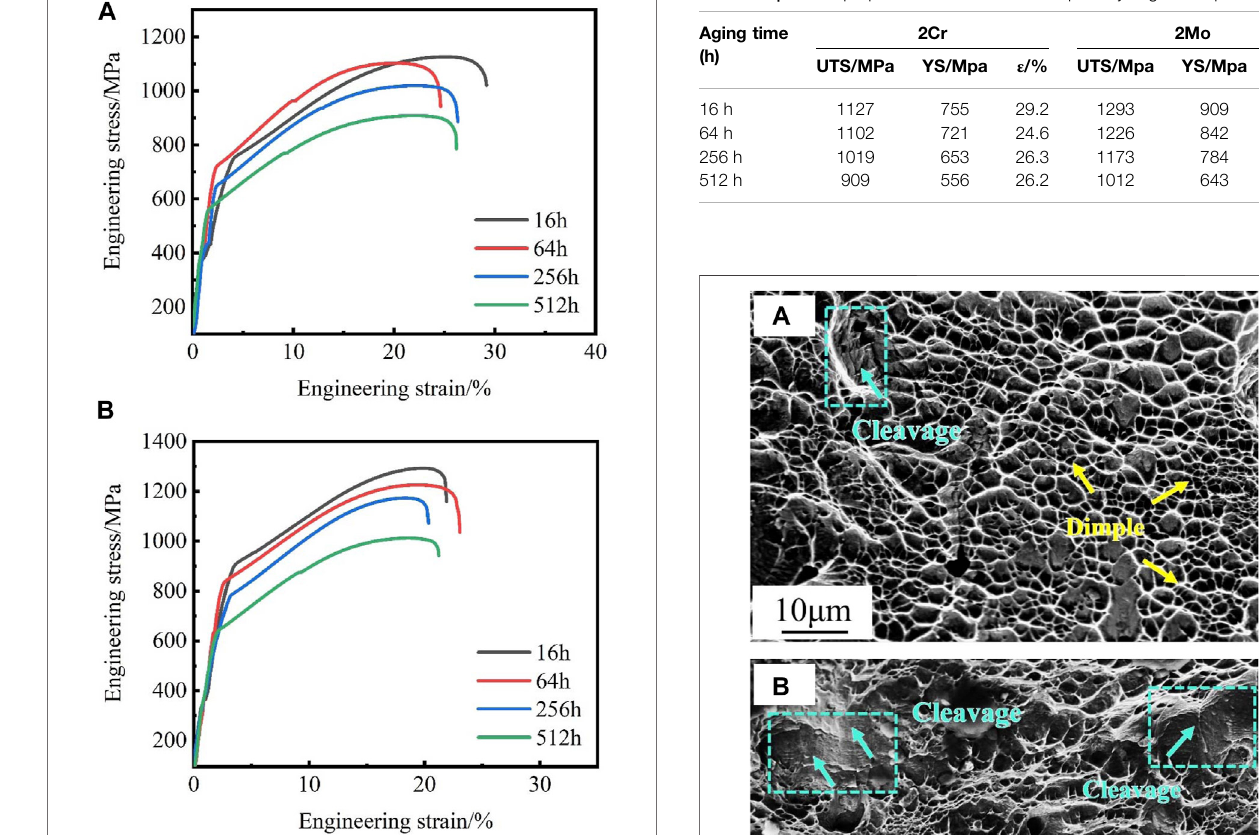
TABLE 2 | Tensile properties of 2Cr and 2Mo superalloys aged samples.